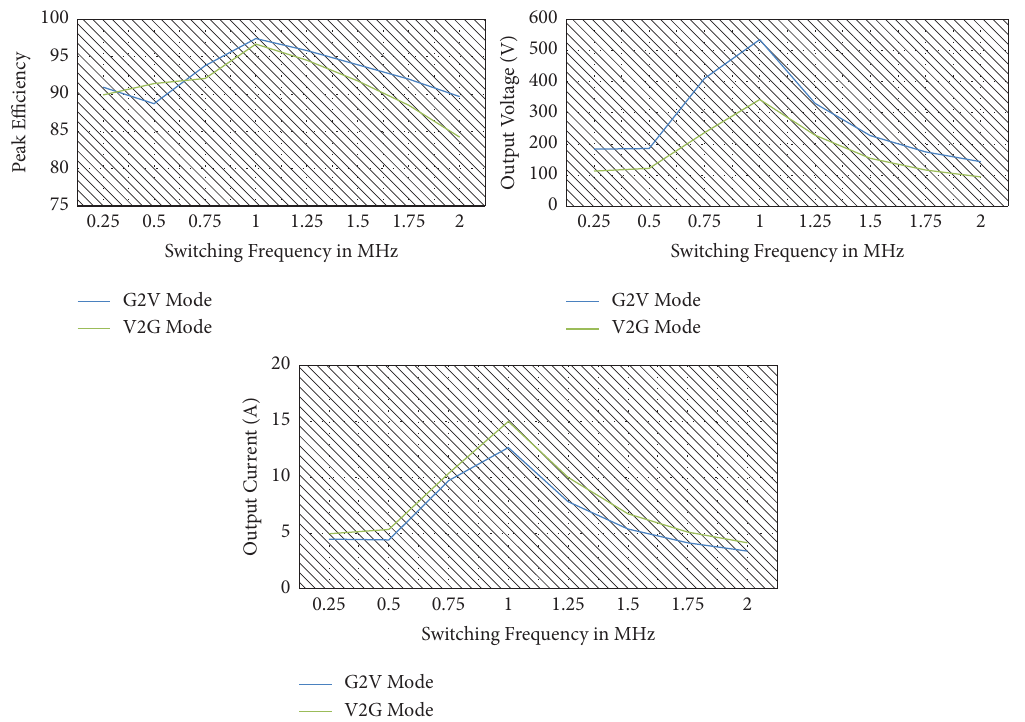
Figure 11: Peak efciency, output voltage, and output current versus operating switching frequency for the converter operating in the G2V and V2G